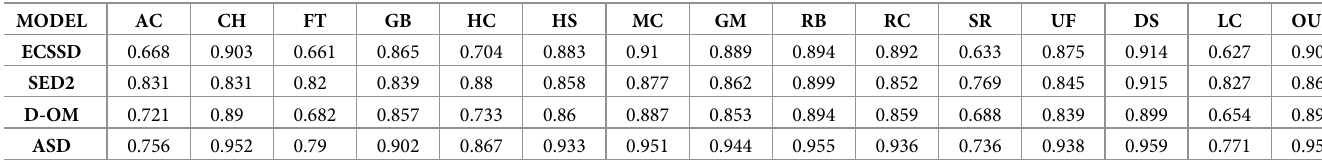
Table 2. Comparison of AUC of the proposed model with current approaches. MODEL